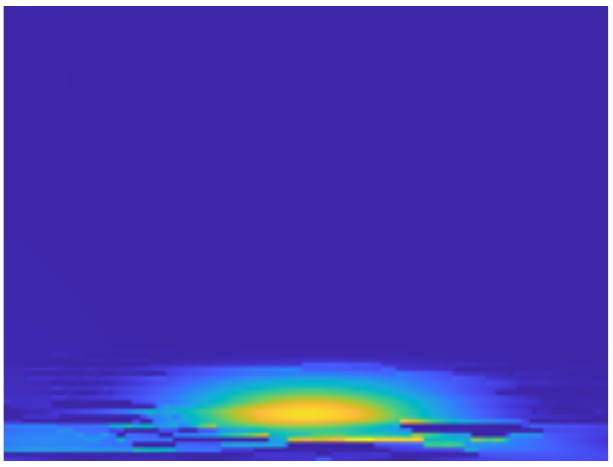
Figure 8. Time – frequency representation by FSST. Figure 8. Time–frequency representation by FSST.